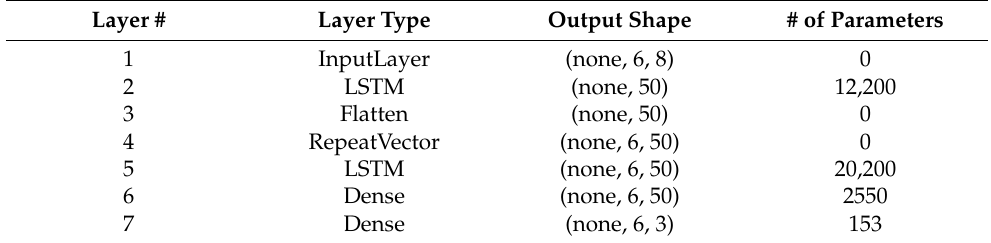
Table 3. Summary of the proposed encoder–decoder storm surge forecast model with a lead time of 6 h. The first column is the layer index, the second is the layer type, the third is the output shape of each layer, and the fourth is the number of training